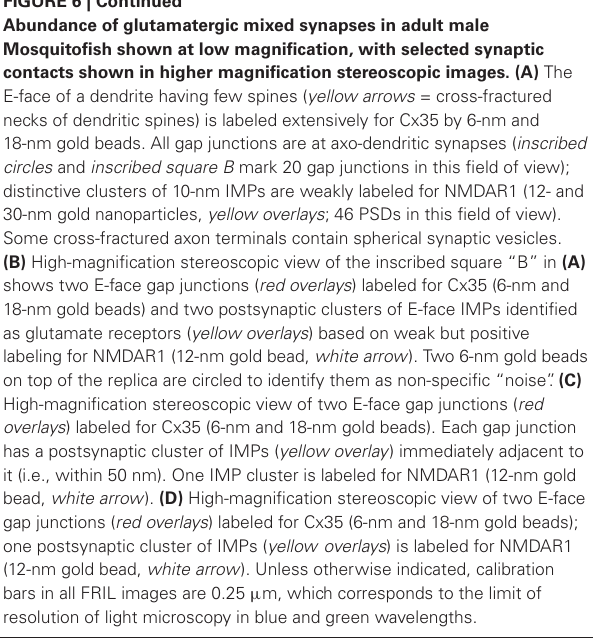
FIGURE 6 | Continued Abundance of glutamatergic mixed synapses in adult male Mosquitofish shown at low magnification, with selected synaptic contacts shown in higher magnification stereoscopic images. (A) The E-face of a dendrite having few spines ( yellow arrows = cross-fractured necks of dendritic spines) is labeled extensively for Cx35 by 6-nm and 18-nm gold beads. All gap junctions are at axo-dendritic synapses ( inscribed circles and inscribed square B mark 20 gap junctions in this field of view); distinctive clusters of 10-nm IMPs are weakly labeled for NMDAR1 (12- and 30-nm gold nanoparticles, yellow overlays ; 46 PSDs in this field of view). Some cross-fractured axon terminals contain spherical synaptic vesicles. (B) High-magnification stereoscopic view of the inscribed square “B” in (A) shows two E-face gap junctions ( red overlays ) labeled for Cx35 (6-nm and 18-nm gold beads) and two postsynaptic clusters of E-face IMPs identified as glutamate receptors ( yellow overlays ) based on weak but positive labeling for NMDAR1 (12-nm gold bead, white arrow ). Two 6-nm gold beads on top of the replica are circled to identify them as non-specific “noise”. (C) High-magnification stereoscopic view of two E-face gap junctions ( red overlays ) labeled for Cx35 (6-nm and 18-nm gold beads). Each gap junction has a postsynaptic cluster of IMPs ( yellow overlay ) immediately adjacent to it (i.e., within 50 nm). One IMP cluster is labeled for NMDAR1 (12-nm gold bead, white arrow ). (D) High-magnification stereoscopic view of two E-face gap junctions ( red overlays ) labeled for Cx35 (6-nm and 18-nm gold beads); one postsynaptic cluster of IMPs ( yellow overlays ) is labeled for NMDAR1 (12-nm gold bead, white arrow ). Unless otherwise indicated, calibration bars in all FRIL images are 0.25 µ m, which corresponds to the limit of resolution of light microscopy in blue and green